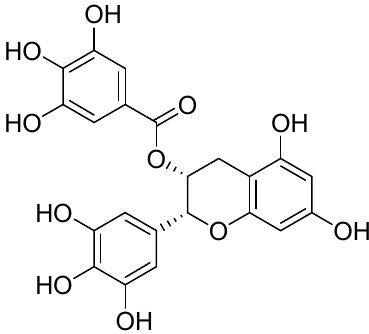
Figure 8. Epigallocatechin gallate.